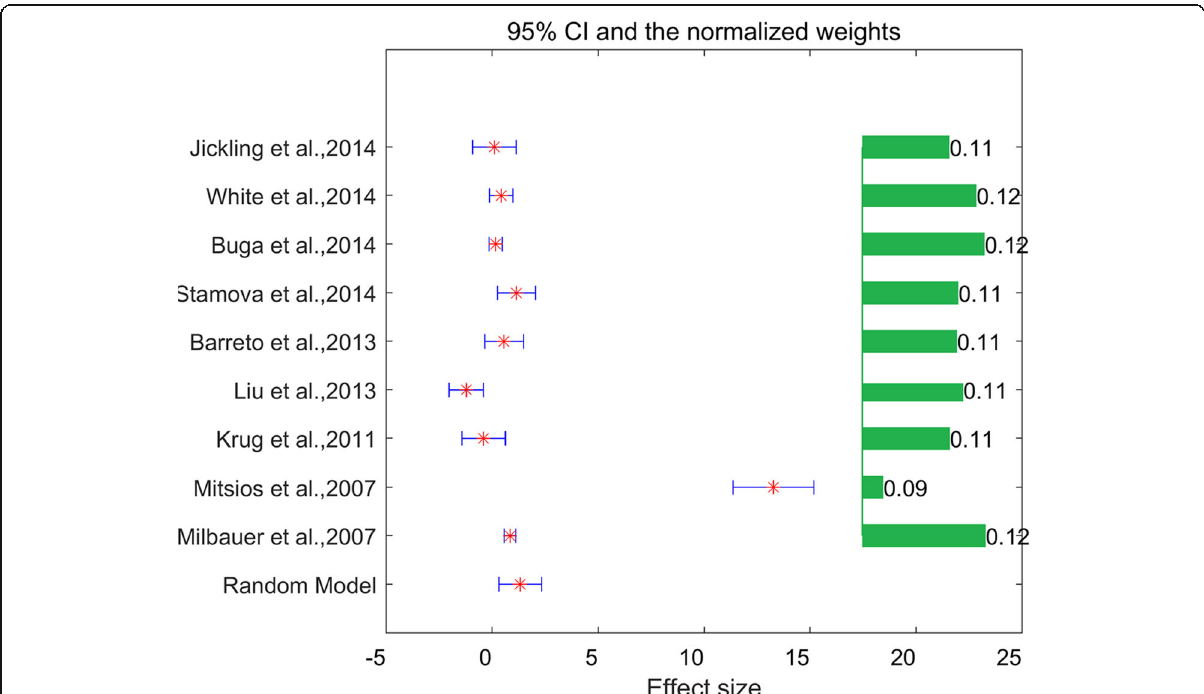
Fig. 1 Mega-analysis results for in the case of stroke. The green bars on the right represent the weight of each datasets; the red stars on the left are the log fold change (LFC) of SP1 within each dataset; the width of the horizontal bar on the left represents the 95% confidence level of the corresponding LFC of